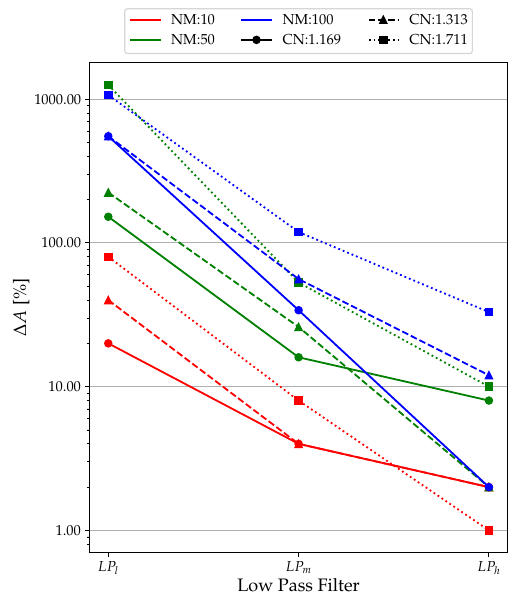
Figure 11. Low-pass filter analysis: ∆ A